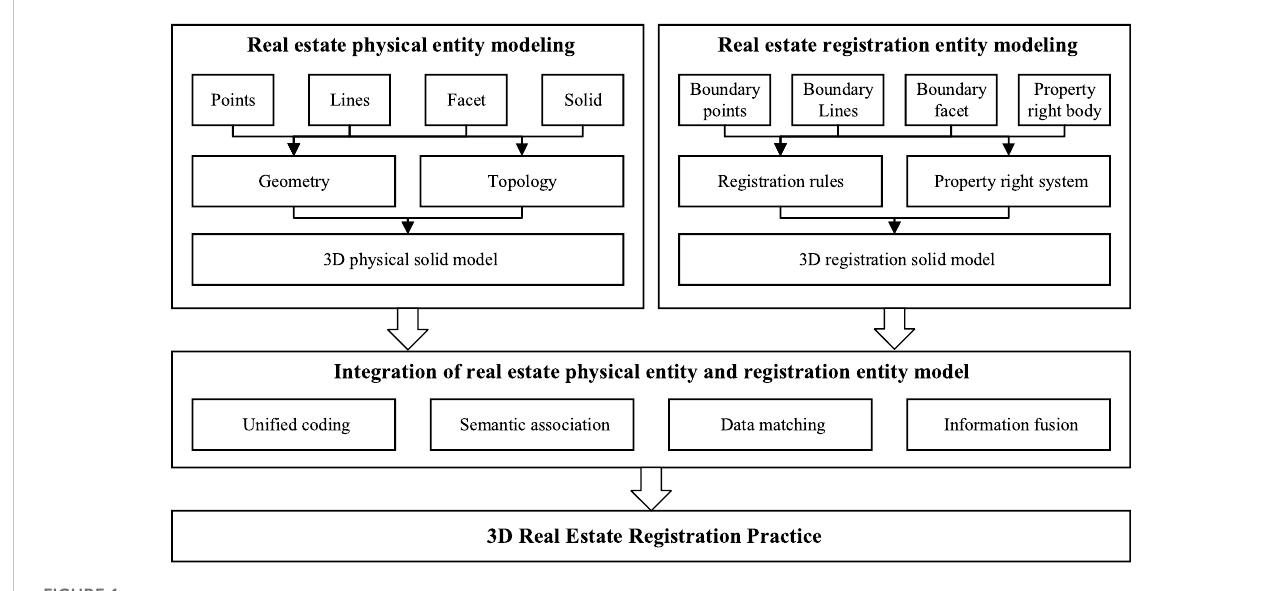
FIGURE 1 Technical roadmap for integration of physical entities and property rights entities.